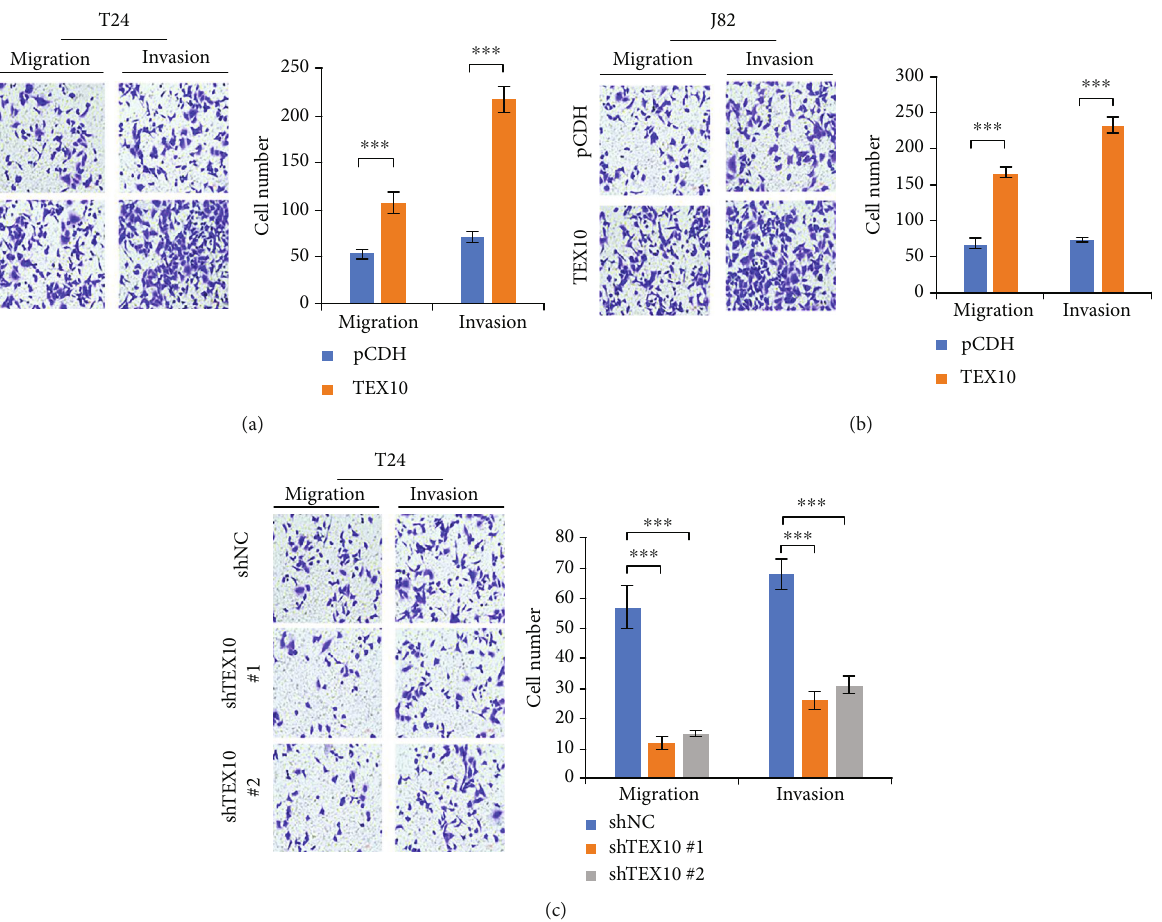
Figure 4: TEX10 promotes urinary bladder carcinoma cell migrating and invading processes. (a, b) T24 and J82 cells which stably expressed pCDH as well as Flag-TEX10 were conducted with Boyden ’ s chamber migration tests (left) as well as Matrigel-coated invasion tests (right). Shown is the mean ± SEM . ∗ P < 0 : 05 ; ∗∗ < 0.01; ∗∗∗ < 0.001, Student ’ s t -test. (c) T24 cells which stably expressed shNC, shTEX10 #1, and shTEX10 #2 were conducted with Boyden ’ s chamber migration tests (left) as well as Matrigel-coated invasion tests (right). Shown is the mean ± SEM . ∗ P < 0 : 05 ; ∗∗ < 0.01; ∗∗∗ < 0.001, Student ’ s t